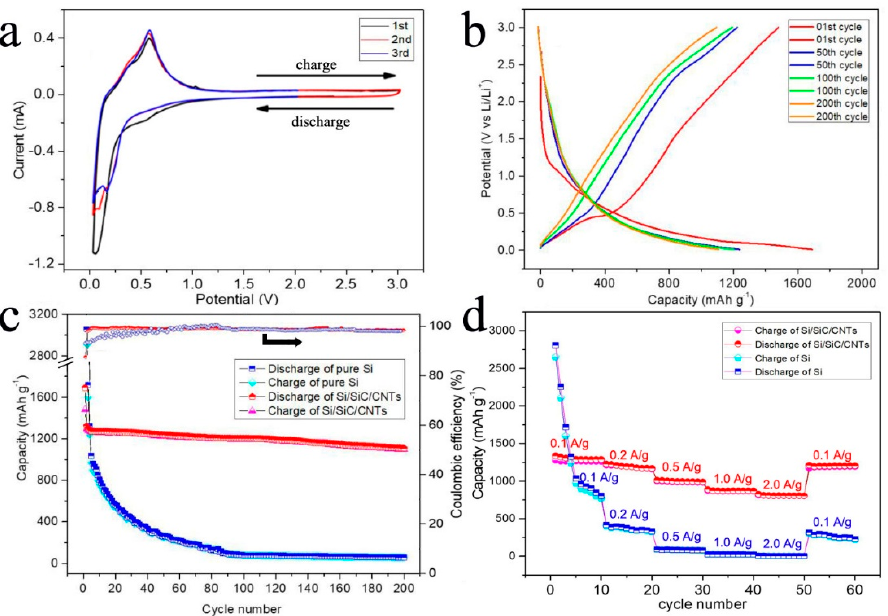
Figure 7. ( a ) Galvanostatic charge/discharge profiles of Si/SiC/CNT nanocomposite; ( b ) CV